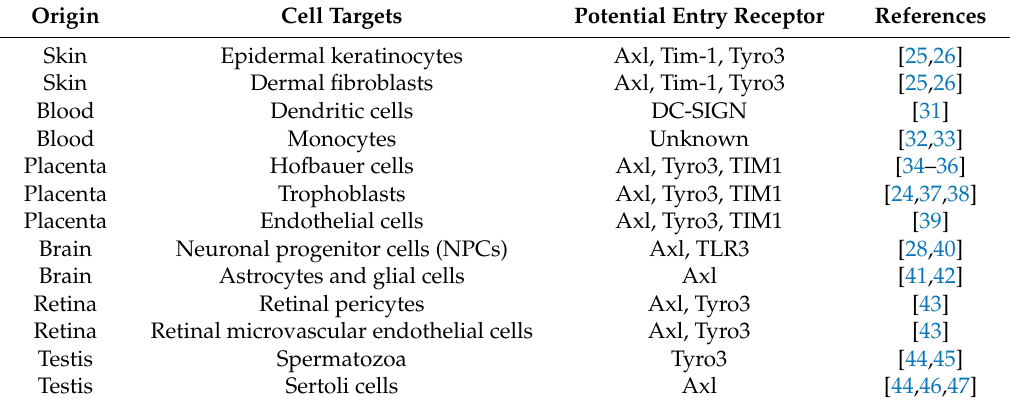
Table 1. Cellular targets and potential entry receptors for